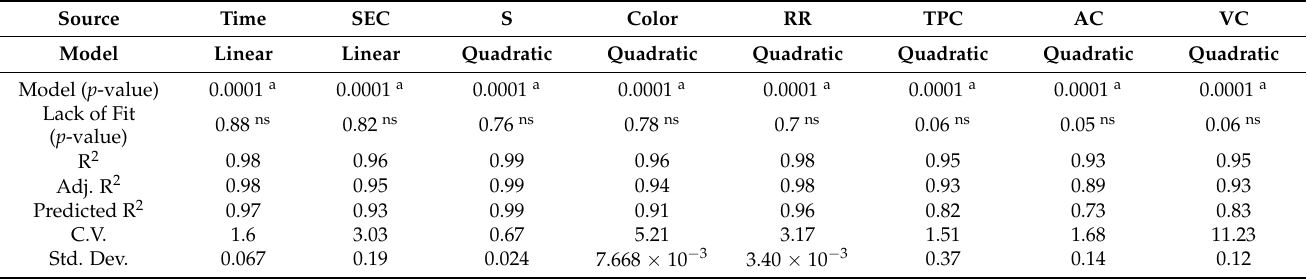
Table 4. Statistical values fitted for dependent variables by RSM.